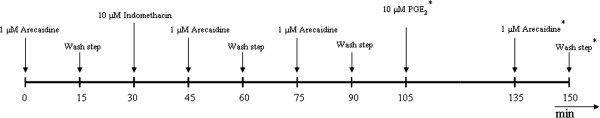
The timeline of the experiments. Pressure recordings started with stimulation of the guinea pig bladder by adding the cholinergic agonist arecaidine to the organ bath with Krebs’ solution in which the isolated guinea pig bladder was kept. After 15 minutes the Krebs’ solution is renewed (wash step). The COX inhibitor indomethacin was added 15 minutes after the first wash step. This was then followed by two sets of arecaidine stimulation and wash steps each separated by 15 minutes. In four experiments PGE2 was added to the organ 15 minutes after the third wash step which was then followed by a set of arecaidine stimulation and wash step, 30 minutes later.